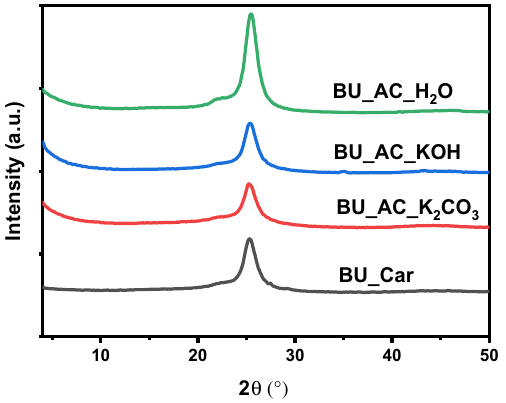
Figure 3. XRD patterns of BU_car, BU_AC_H 2 O, BU_AC_K 2 CO 3 , and, BU_AC_KOH.